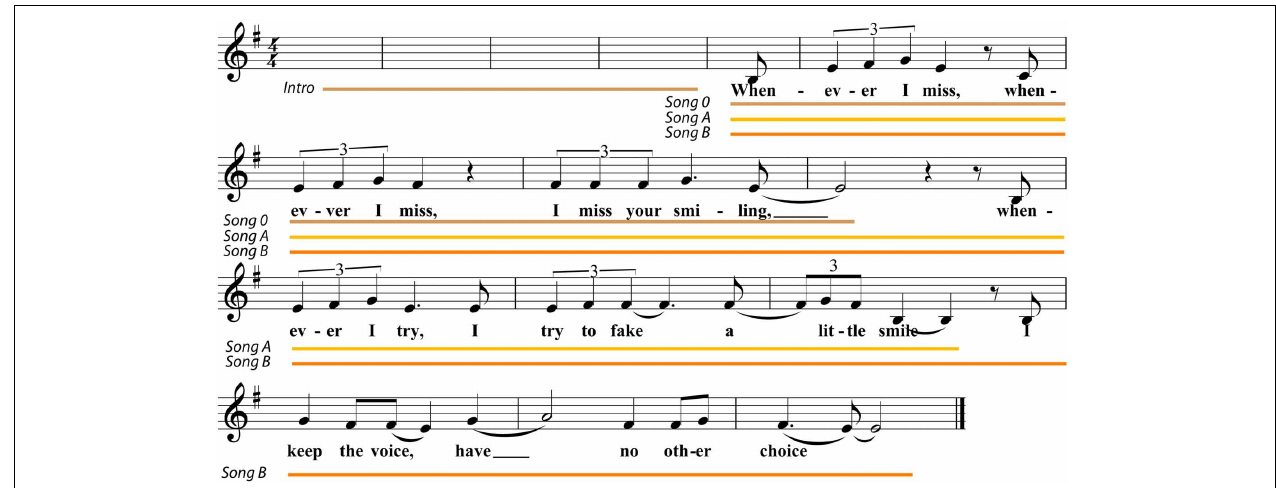
FIGURE 1 | The lyrics of the unknown song. This figure represents the text and the song Whenever which was unknown to all participants. The first part (the brown line 0) was not part of the evaluation as it was a familiarization